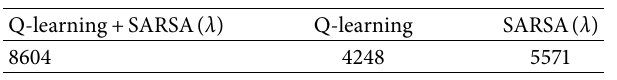
Table 2: Average number of squares per 20 steps in 200-step